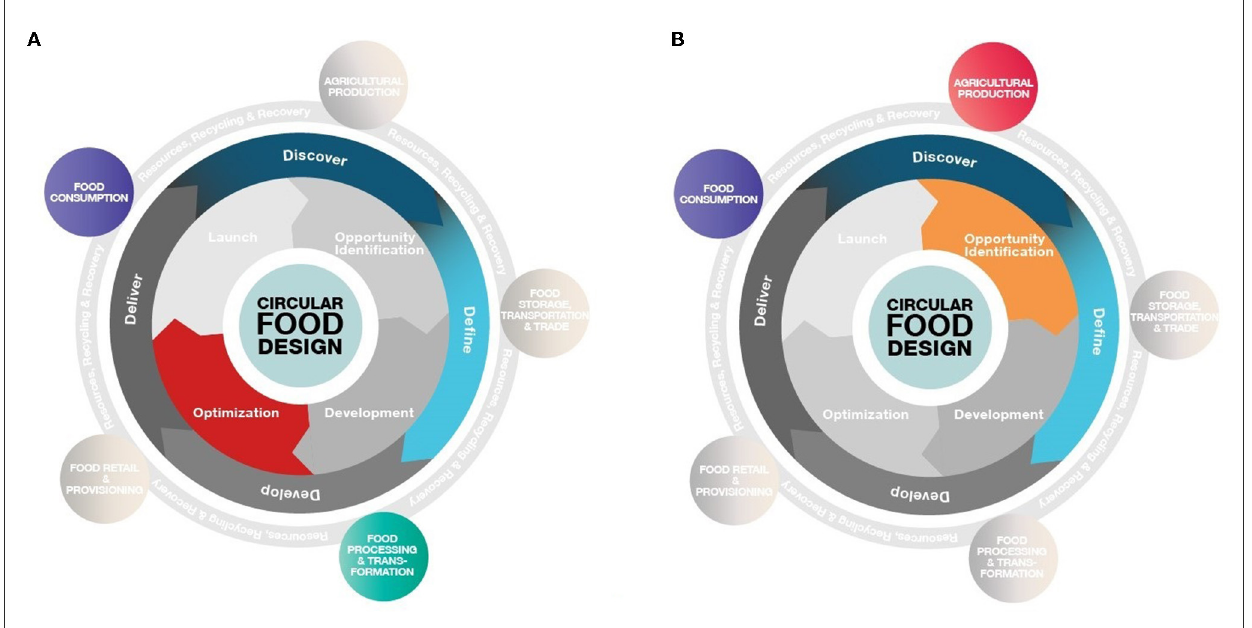
FIGURE1 Circular food design applied to tomato (A) and bell pepper (B)